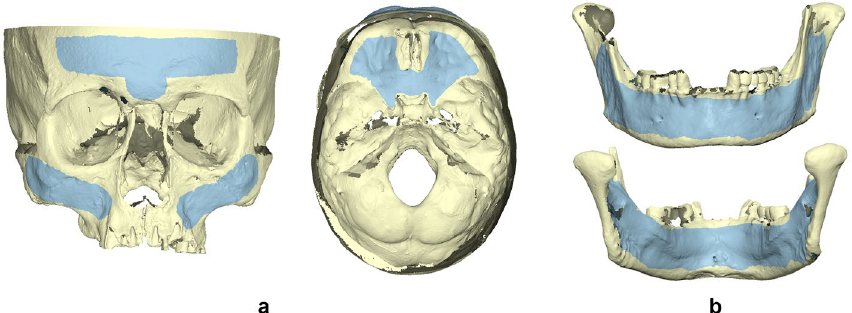
Figure 1. Superimposition reference areas used in the ( a ) skulls and ( b ) mandibles (top: buccal aspect, bottom: lingual aspect) to register corresponding 3D surface models, depicted in light blue color. Adapted from: Probst et al . Diagnostics 2022, 12, 2251. https:// doi. org/ 10. 3390/ diagn ostic s1209 2251 11 .